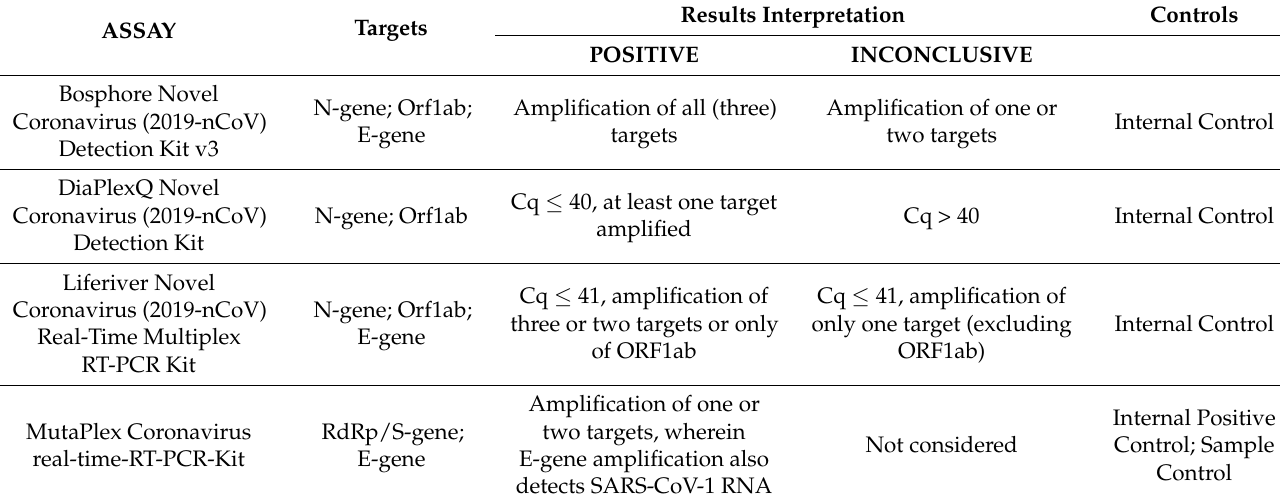
Table 1. Manufacturer characteristics and results interpretation of SARS-CoV-2 RT-qPCR detection kits. ASSAY